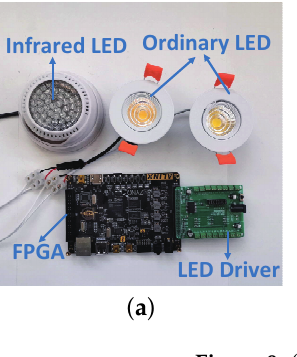
Figure 9. ( a ) Transmitter and ( b )